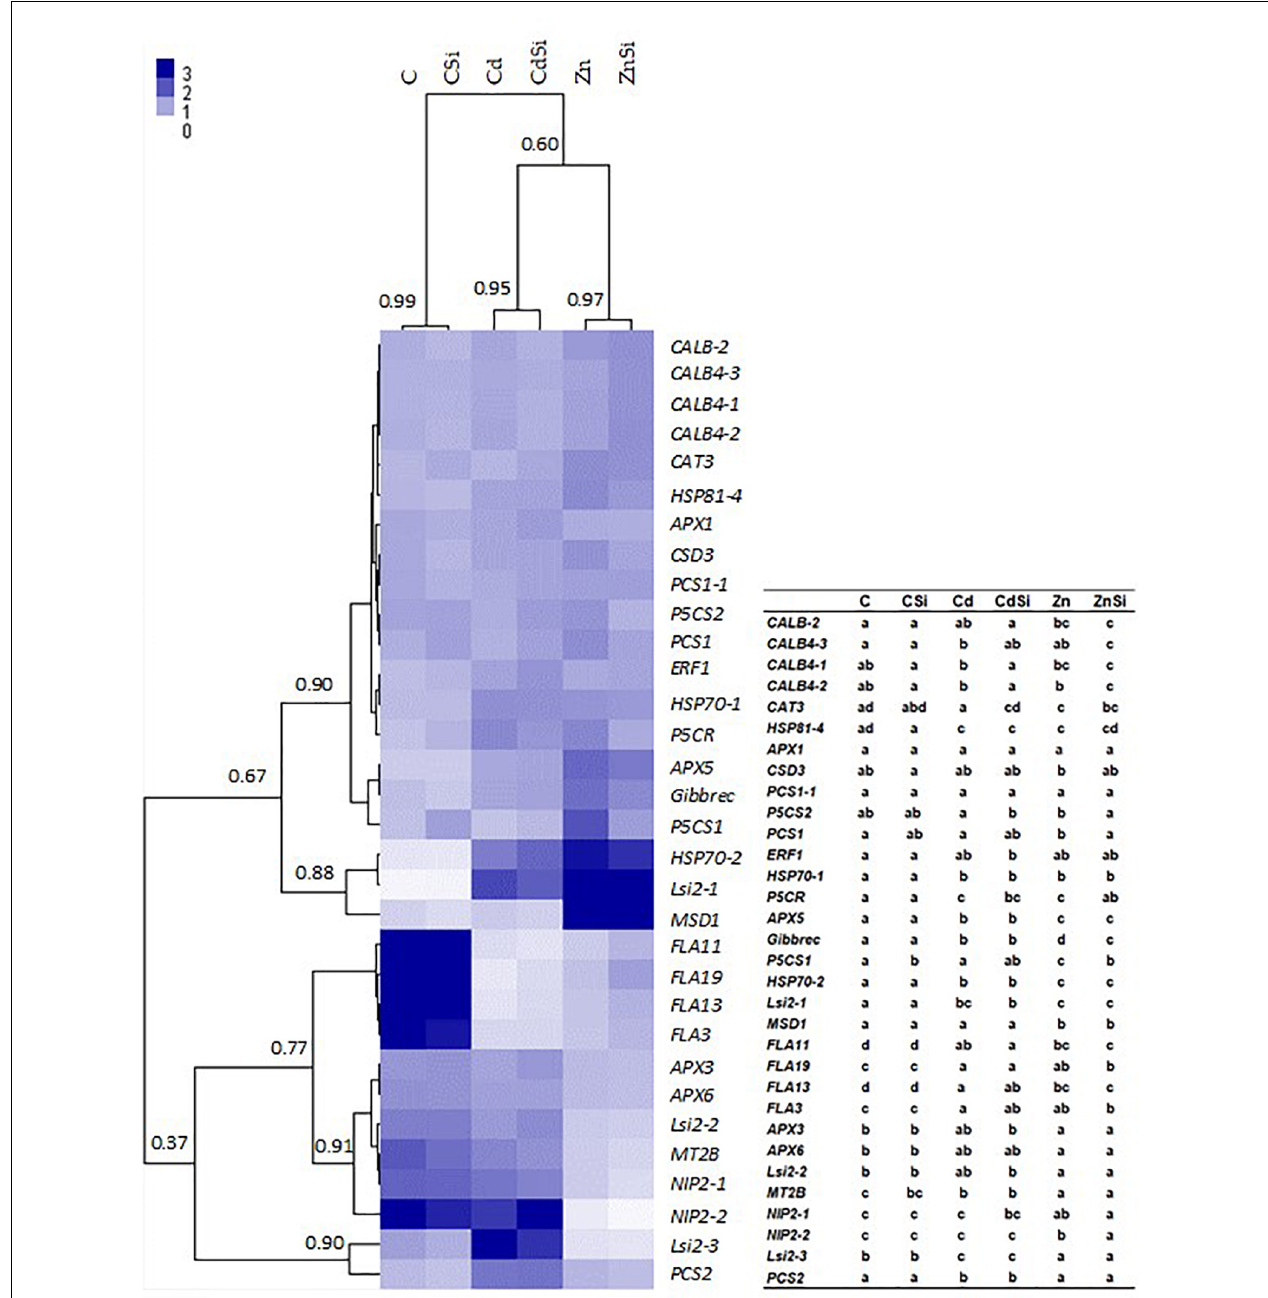
FIGURE 4 | Heatmap hierarchical clustering showing the expression of genes assessed by RT-qPCR in the roots of hemp plants. Plants were exposed for 1 week to Cd (20 µ M) or Zn (100 µ M) in the presence or absence of Si (2 mM) (C: control plants not exposed to HM). The values represent NRQs. For each group, the Pearson’s coefficient is provided. The table represents statistical analyses of the heatmap hierarchical clustering. The different letters indicate that the values are significantly different from each other ( p < 0.05; Tukey’s HSD all-pairwise comparisons).